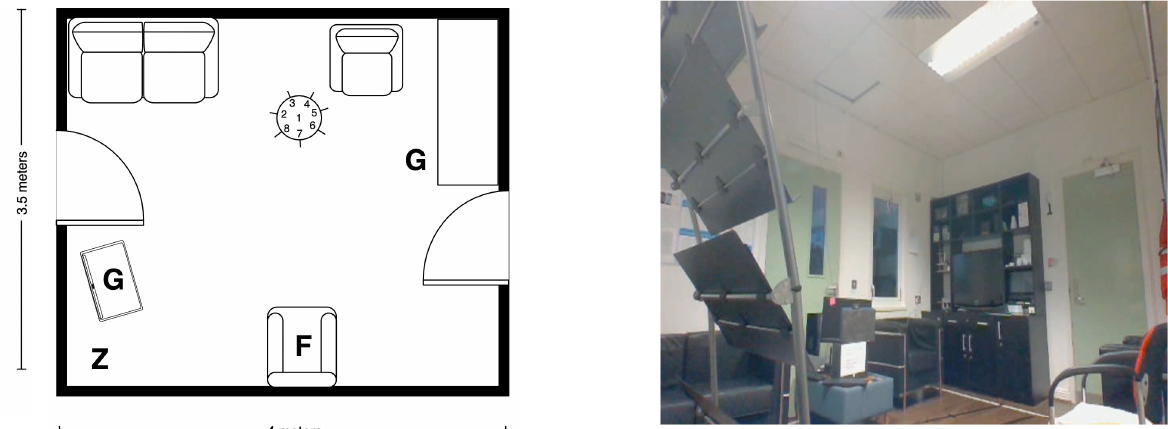
Figure 5. Sketch and photograph of the living conditioned with couches. The photograph was taken from position